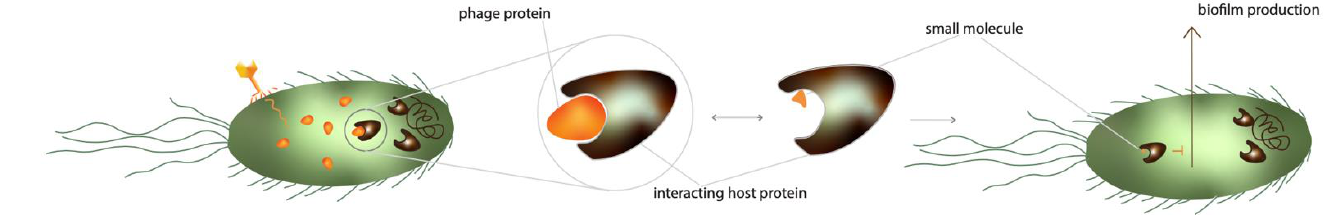
Figure 3. Workflow for basic research on studying phage anti-biofilm proteins for designing small mimetic molecules . When phage anti-biofilms are discovered, their interacting host proteins can be uncovered. Studying the predator–host protein–protein interaction enables us to design or screen for small molecules that will mimic the anti-biofilm effect of the phage protein; these small molecules can then be used as a drug to spur antibiotics’ effect or as an anti-biofilm component in industrial settings.